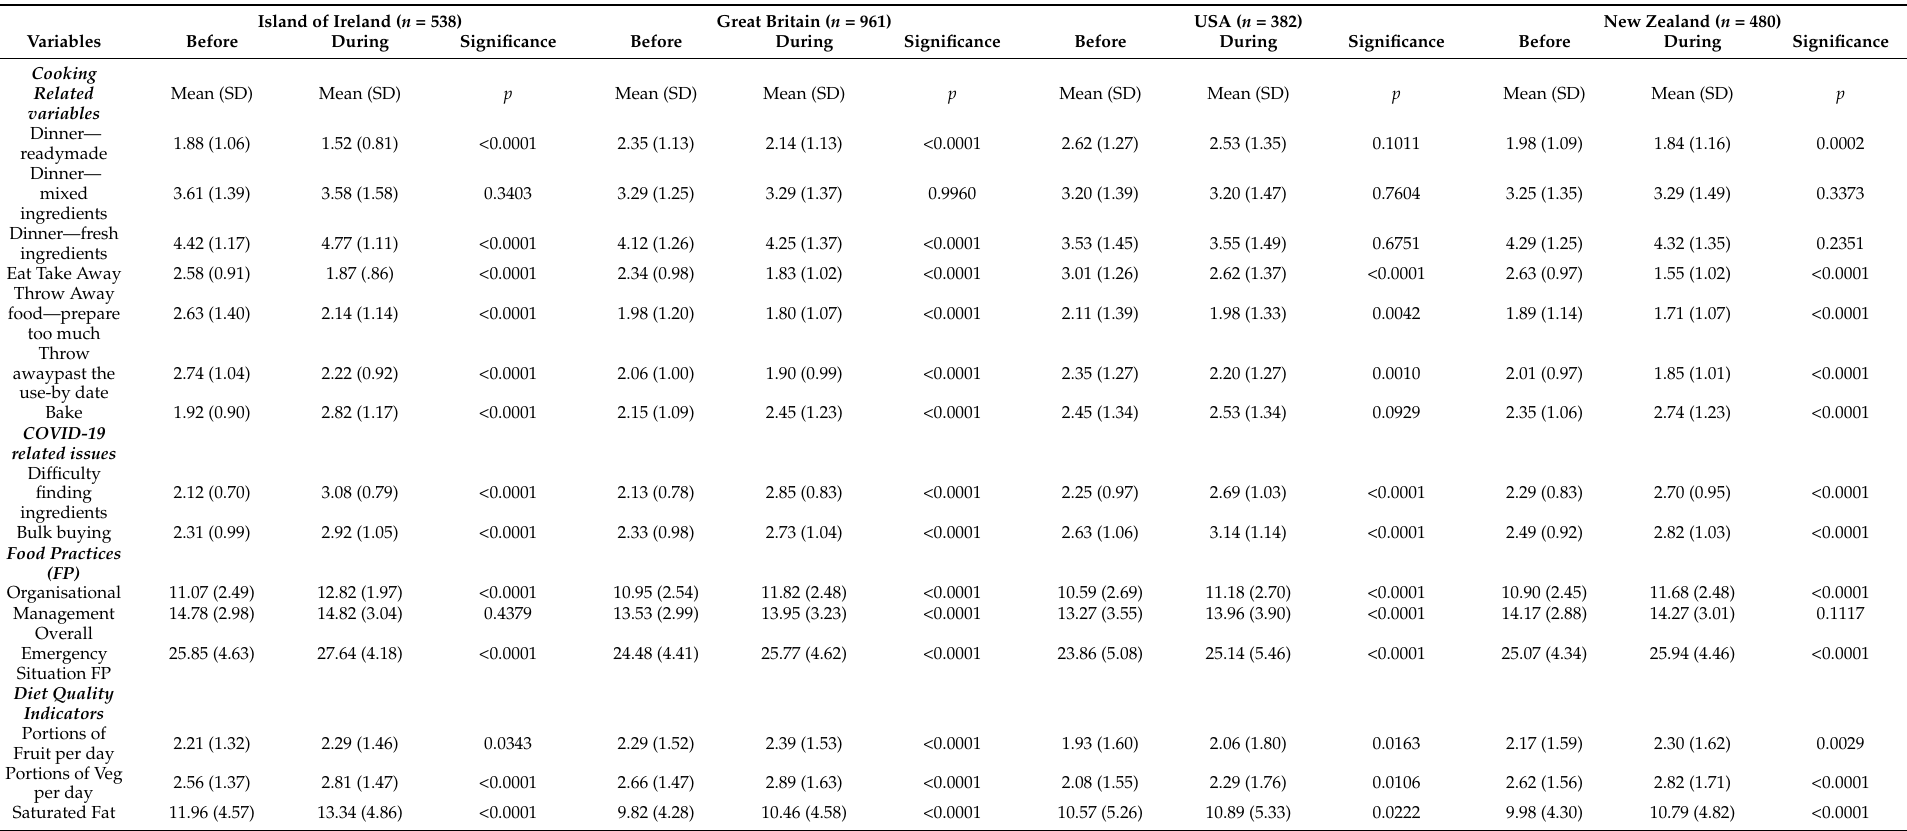
Table 2. Within region differences before the COVID-19 pandemic to during it on a number of food related variables and on Emergency Situation Food Practices. Island of Ireland ( n = 538) Great Britain ( n = 961) USA ( n = 382) New Zealand ( n = 480)